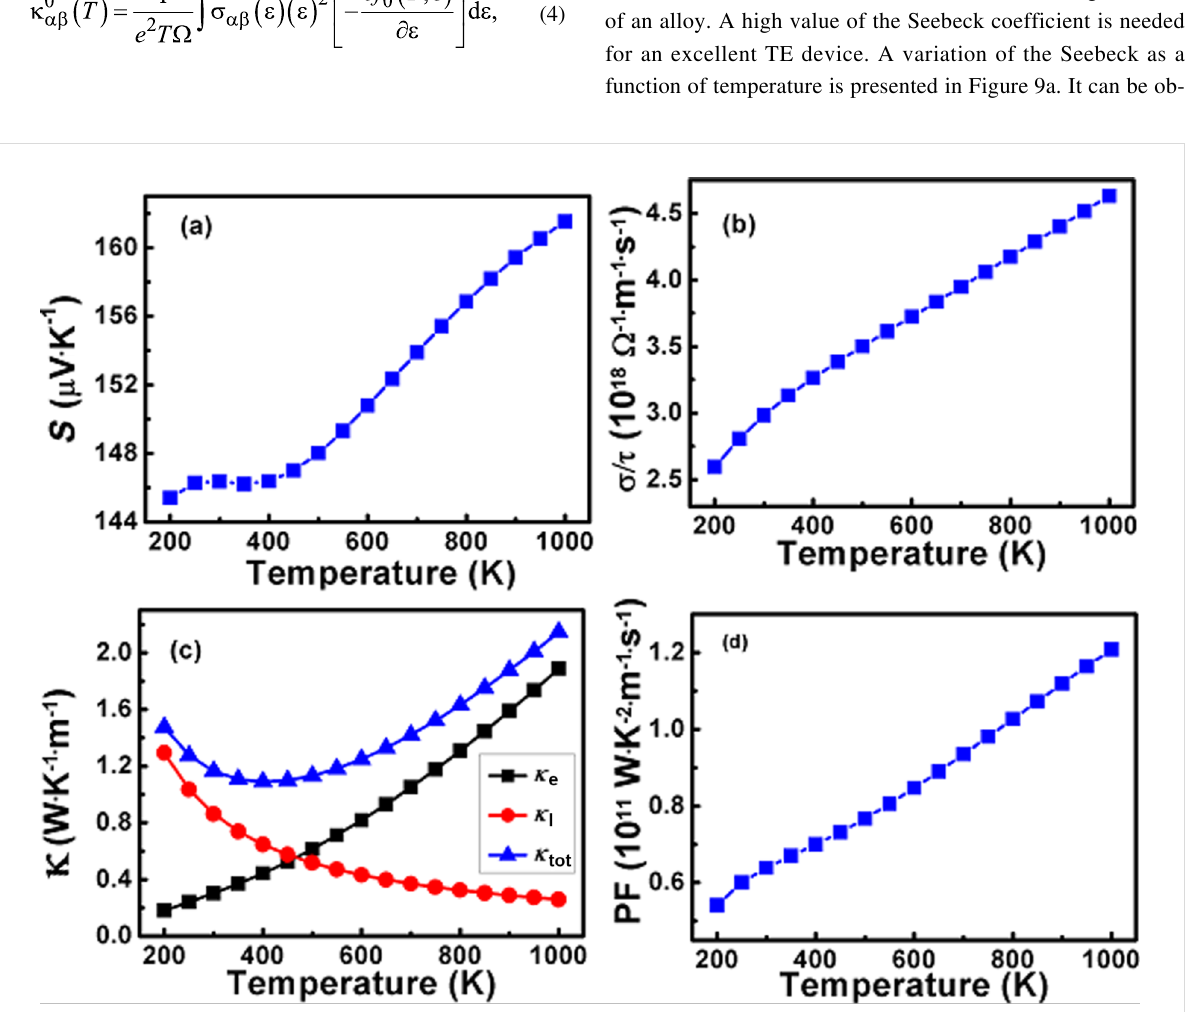
Figure 9: Temperature-dependent (a) Seebeck coefficient ( S ); (b) electrical conductivity ( σ / τ ); (c) electronic ( κ e ), lattice ( κ l ), and total ( κ tot ) thermal conductivity values and (d) power factor (PF) of the π -SnSe